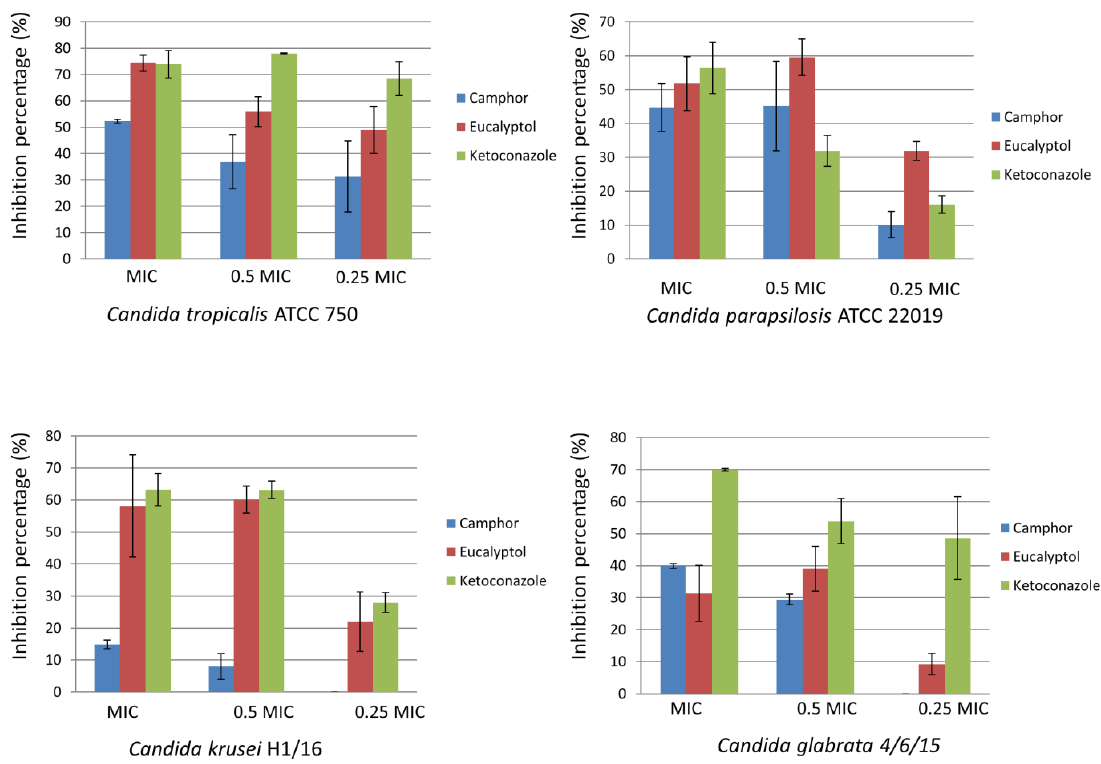
Figure 2. Inhibition of non-albicans Candida biofilm formation after treatment with camphor, eucalyptol and ketoconazole, expressed as inhibition percentage (100% means no biofilm was established), values represent means ± SD of three replicates.